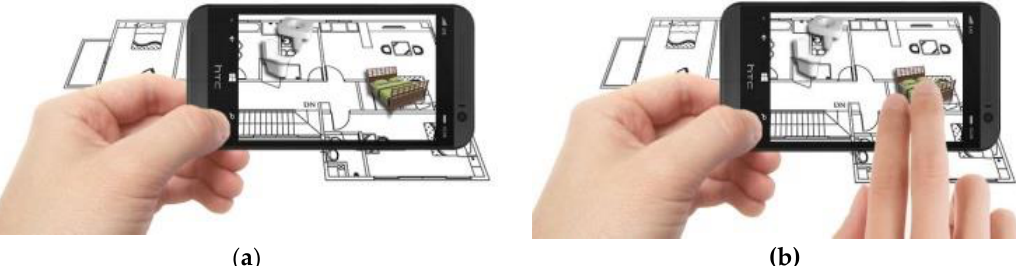
Figure 3. ( a ) AR-based simulation of 2D interior design layout plans and integration of 3D images of interior design symbols; ( b ) Students can evaluate different design decisions by moving 3D objects in AR on their mobile phone screens.